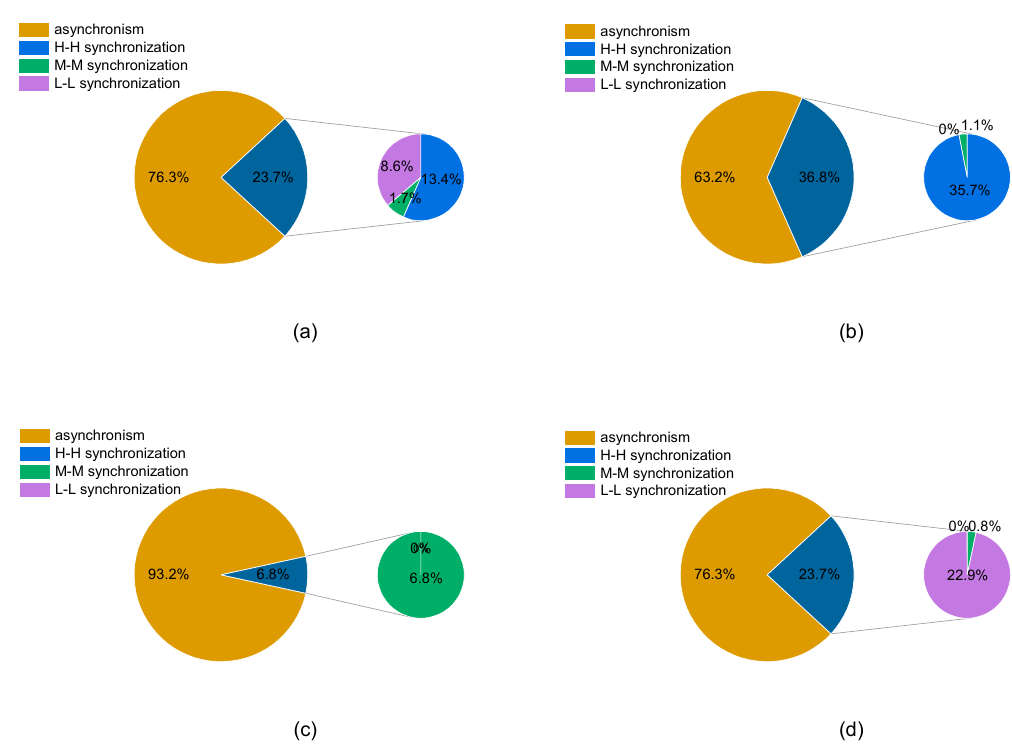
Figure 6. The synchronous and asynchronous probabilities of wet–dry encounters occurring in the Yellow River Basin and its regions ( a ), the synchronous and asynchronous probabilities of wet–dry encounters occurring in the regions under the high flow year in the Yellow River Basin ( b ), the synchronous and asynchronous probabilities of wet–dry encounters occurring in the regions under the medium flow year in the Yellow River Basin ( c ), the synchronous and asynchronous probabilities of wet–dry encounters occurring in the regions under the low flow year in the Yellow River Basin ( d ).